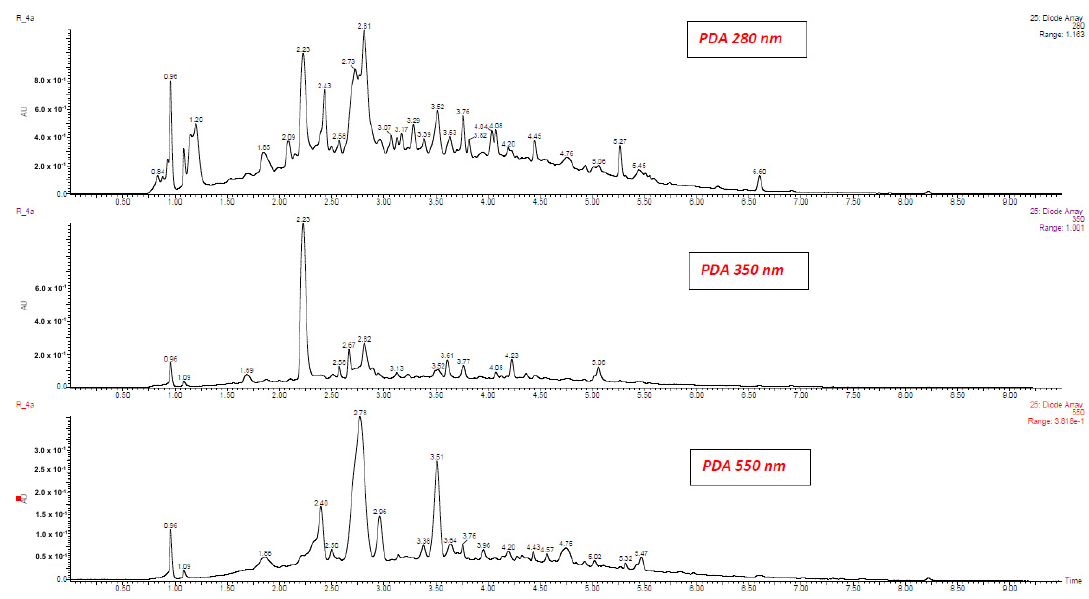
Figure 3. UPLC-PDA chromatograms of phenolic compounds in Rondo wine at 280, 350 and 550 nm .